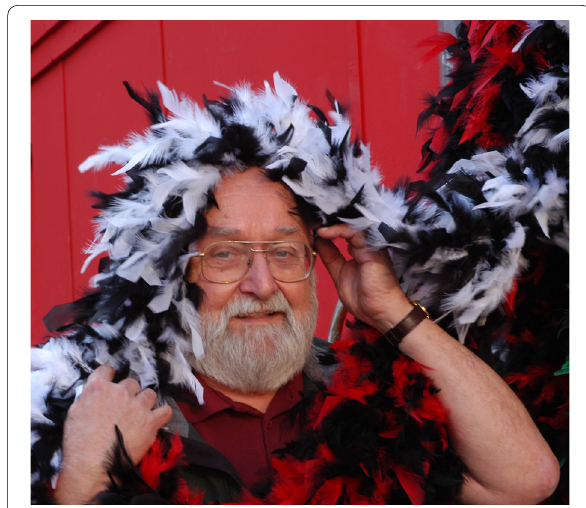
Fig. 21 ”Jim” and Trappe having fun, Plaza de Major, Madrid,